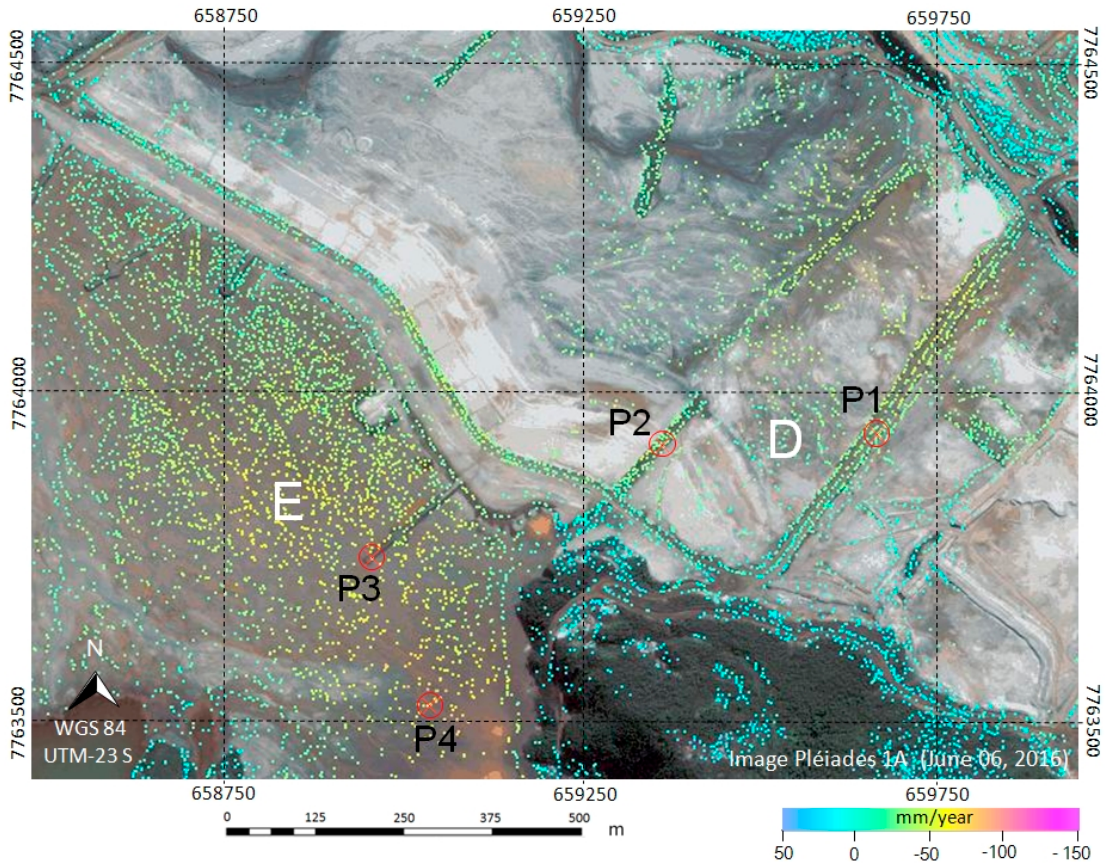
Figure 20. PSI ground displacement map in LoS showing the auxiliary dikes in sector (D) and the Baía 3 dam and its reservoir in sector (E) and the points P1, P2, P3, and P4 selected for plotting of the ground displacement.